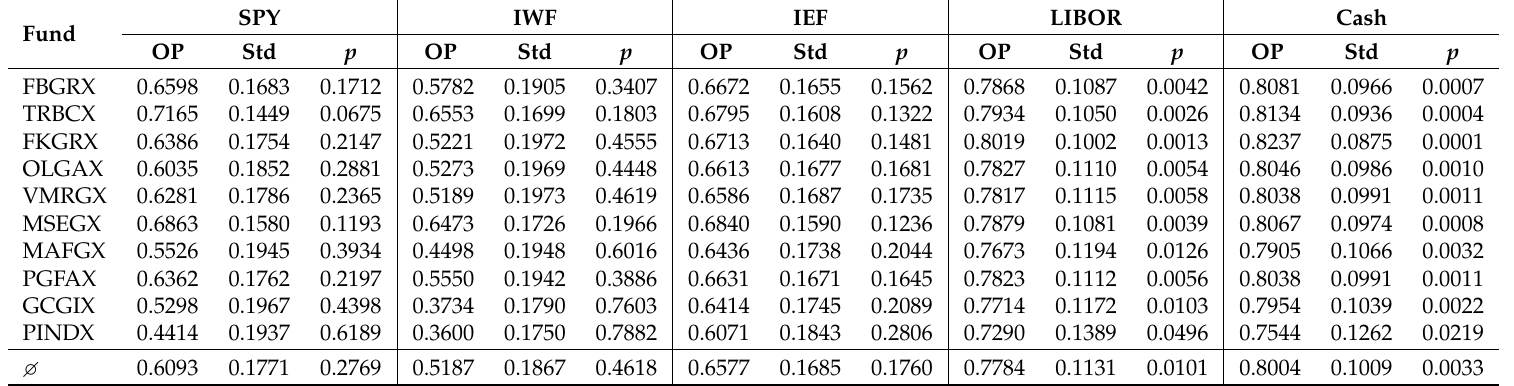
Table 7. Results in the case that T is exponentially distributed with λ =